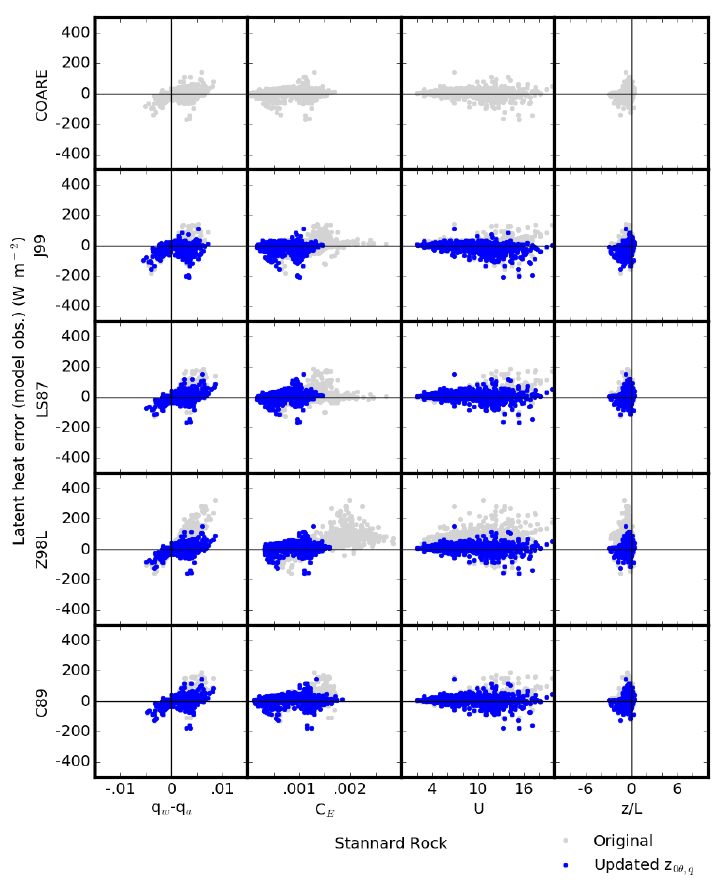
Figure 10. Errors in daily mean latent heat flux ( y axis) versus specific humidity difference between the water’s surface and air at the sensor height q w − q a (kgkg − 1 ), transfer coefficient C E (–), wind speed U (ms − 1 ), and stability factor z/L ( x axis) for the five algorithms at Stannard Rock. Gray and blue dots indicate the results using the original and updated z 0 ,q formulae,